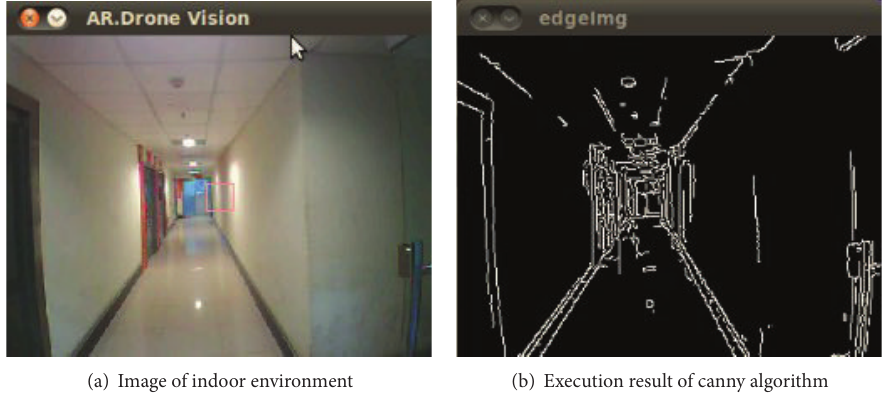
Figure 3: Edge detection of indoor flight environment.